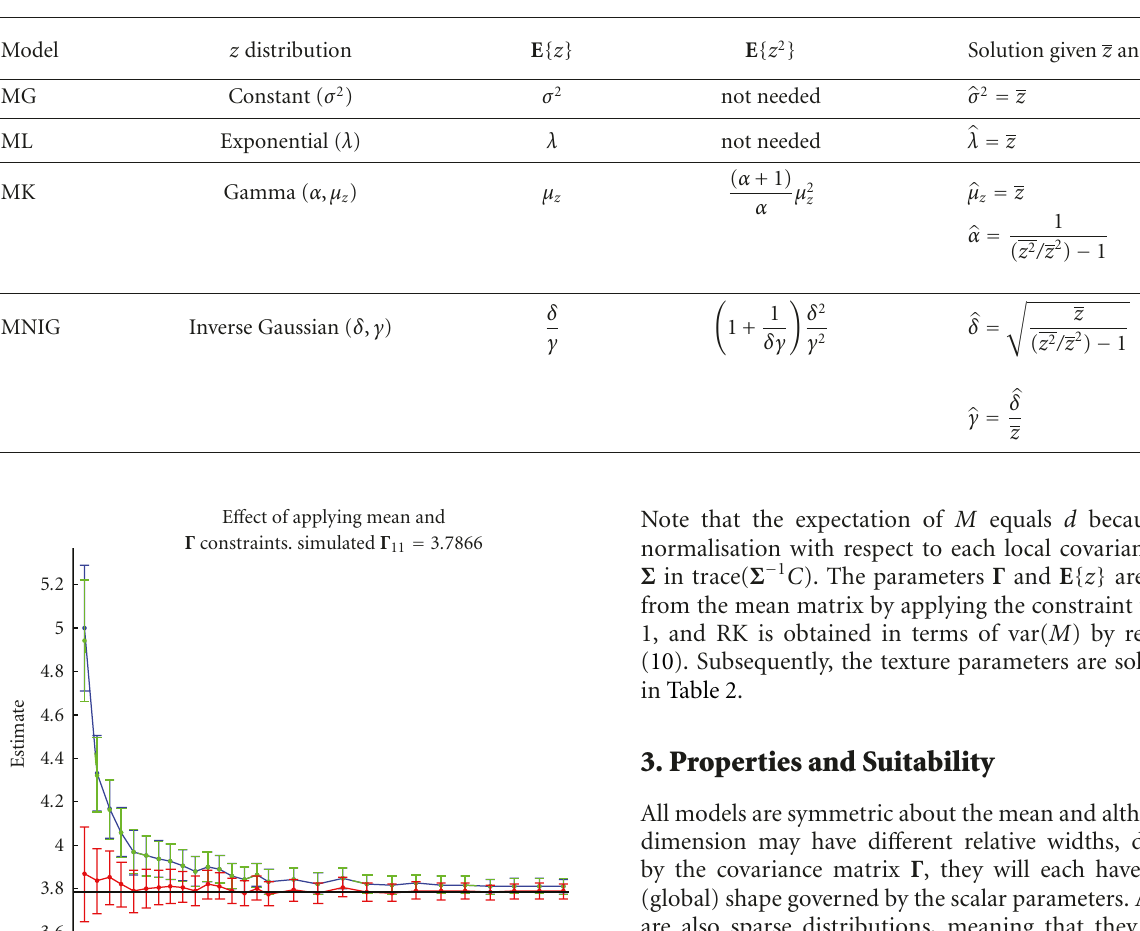
Table 2: Moment expressions and parameter solutions for each model.